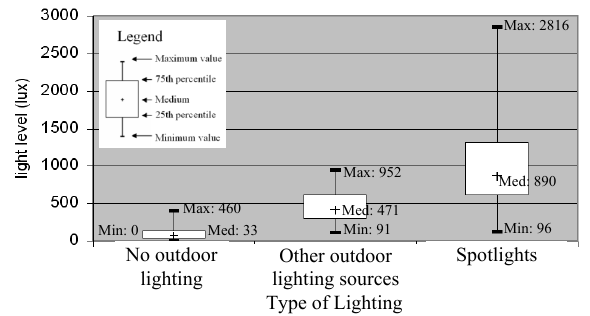
Figure 13. Statistics of SLL for the types of outdoor lightings It is seen from Figure 13 that the light level of these three types of lighting is different. The light level of the third type is the lowest of the three. The 75th quartile of the data is lower than the minimum value of the first and second types. The data value, larger than the 75th quartile may be due to the high light level trespassing from indoor lighting. The second type lighting is in the middle of these three types. The value of the 75th quartile is lower than the 25 th quartile of the first type lighting (spotlights). This means that the value of the majority of the sample data is lower than first type lighting. The first type lighting, is obviously the highest, and was achieved only on sites where spot lights shone directly onto the pavement. The value range of the data is relatively large, quite probably due to the strength of the brightness of the spot lights.